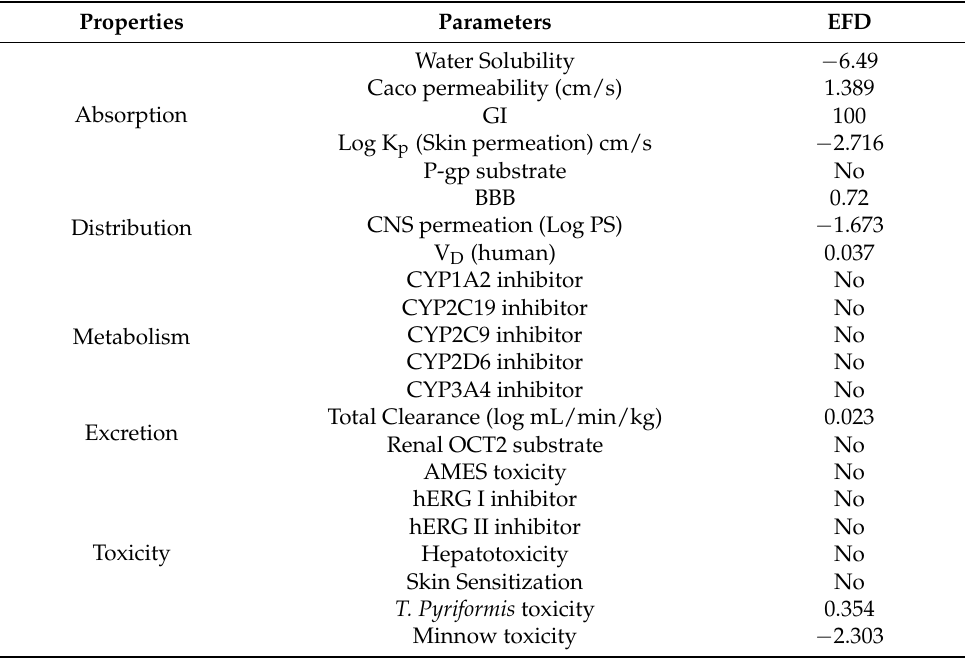
Table 7. Prediction of the ADMET profile of